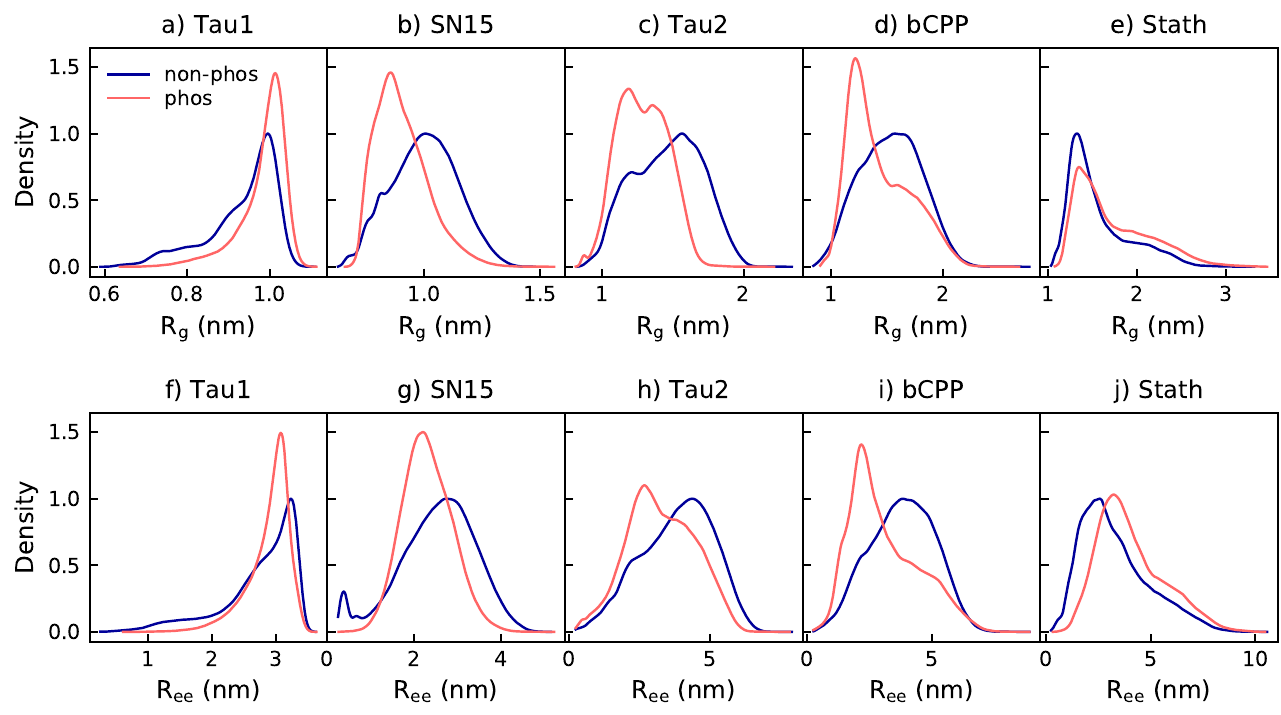
Figure 1. Radius of gyration (R g ) and end-to-end distance (R ee ) density distributions of the non-phosphorylated (non-phos) and phosphorylated (phos) variants. The SN15 data are obtained from Ref. [20] (2020 American Chemical Society), and data for the phosphorylated variants of Tau2, bCPP, and Stath from